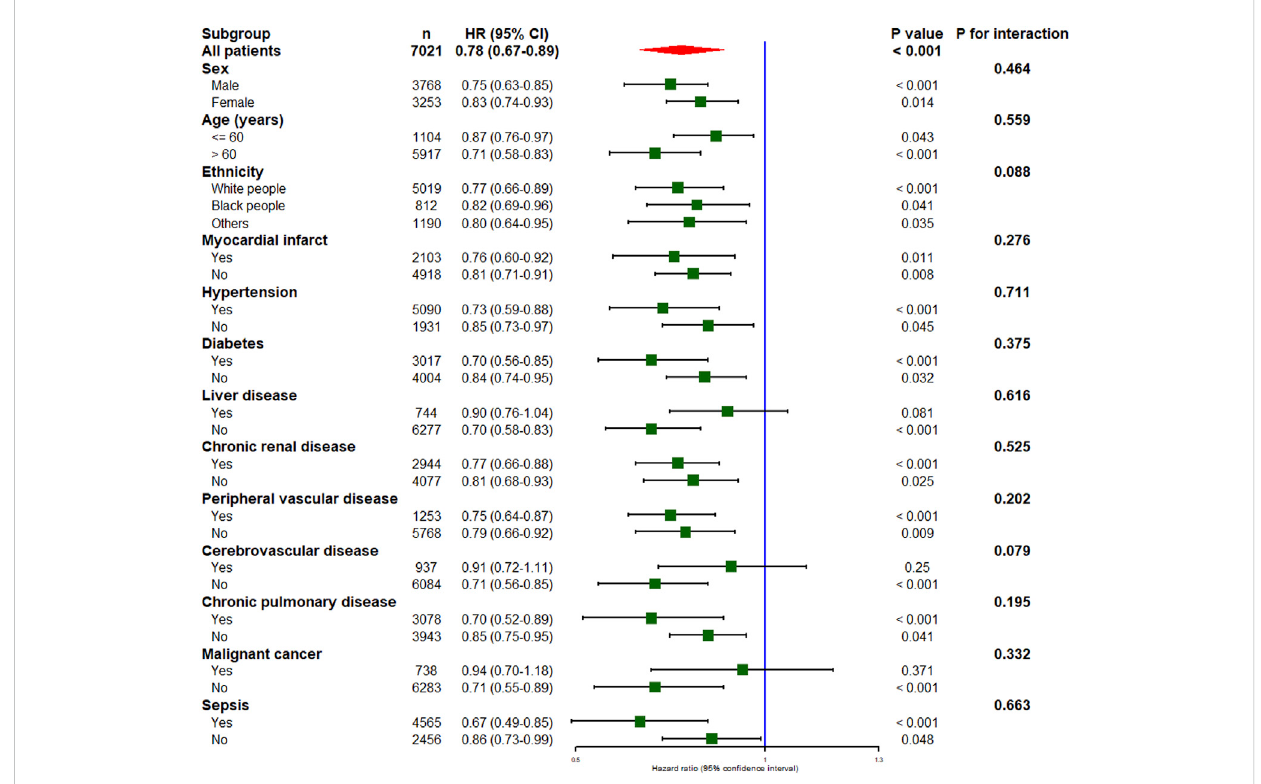
FIGURE 3 Subgroup analysis of the association between thiamine use and in-hospital mortality in critically ill patients with heart failure. HR, hazard ratio; CI, con fi dence